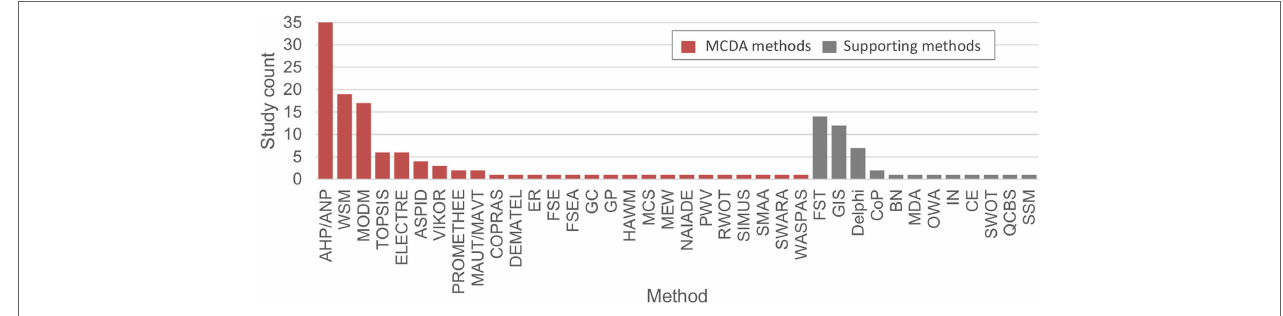
FiGURe 10 | Multicriteria decision analysis (MCDA) and supporting methods used in the reviewed studies . Note: ELECTRE encompasses also ELECTRE III and TRI; PROMETHEE encompasses also